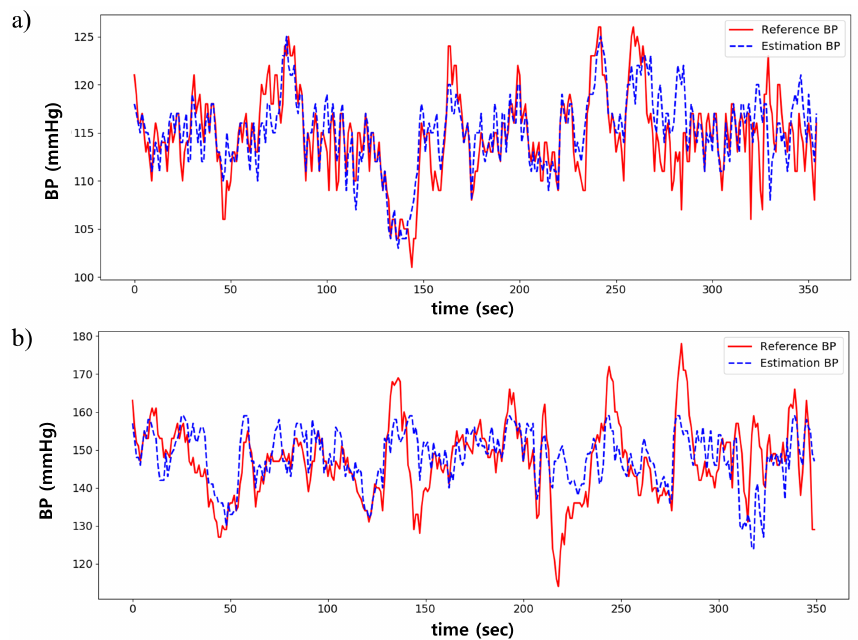
Figure 12. Comparison between estimated and reference BP. ( a ) is the best case; ( b ) is the worst case.